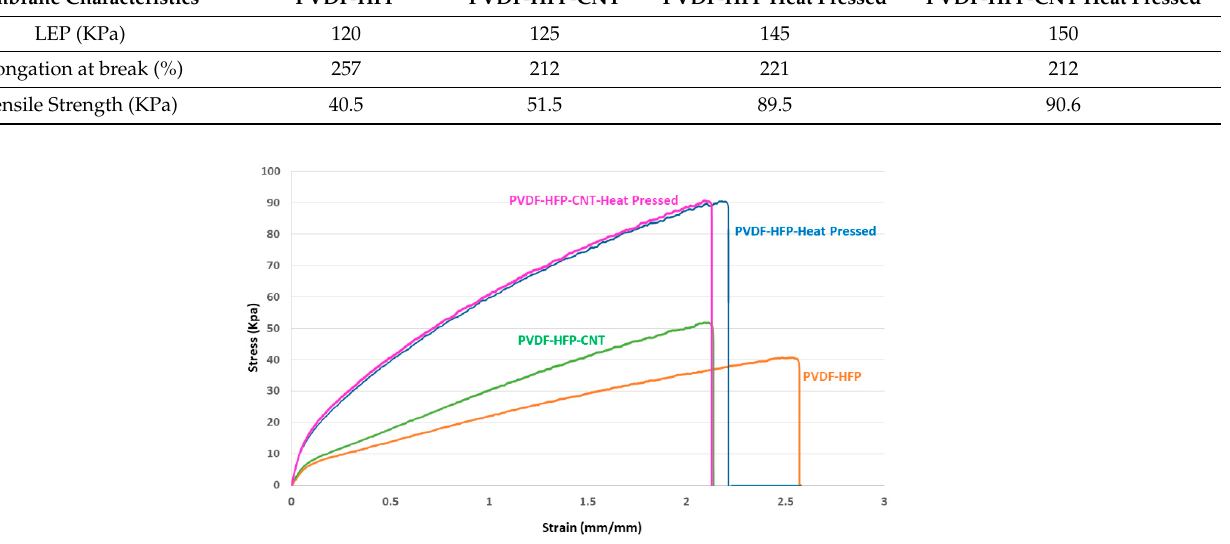
Table 3. LEP and tensile characteristics of the PVDF ‐ HFP and PVDF ‐ HFP ‐ CNT membranes before and after heat pressing.